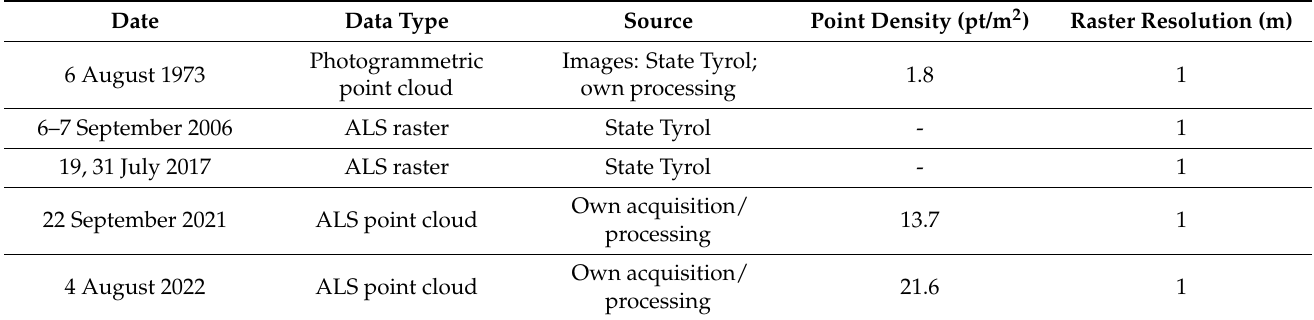
Table 1. Information on the DEMs used in this